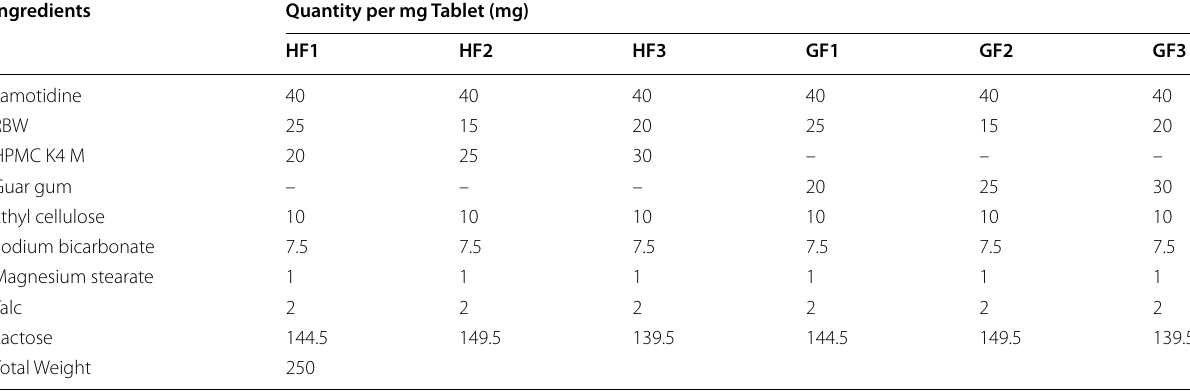
Table 1 Preliminary trial batch composition containing HPMC K4 M and RBW, guar gum and RBW